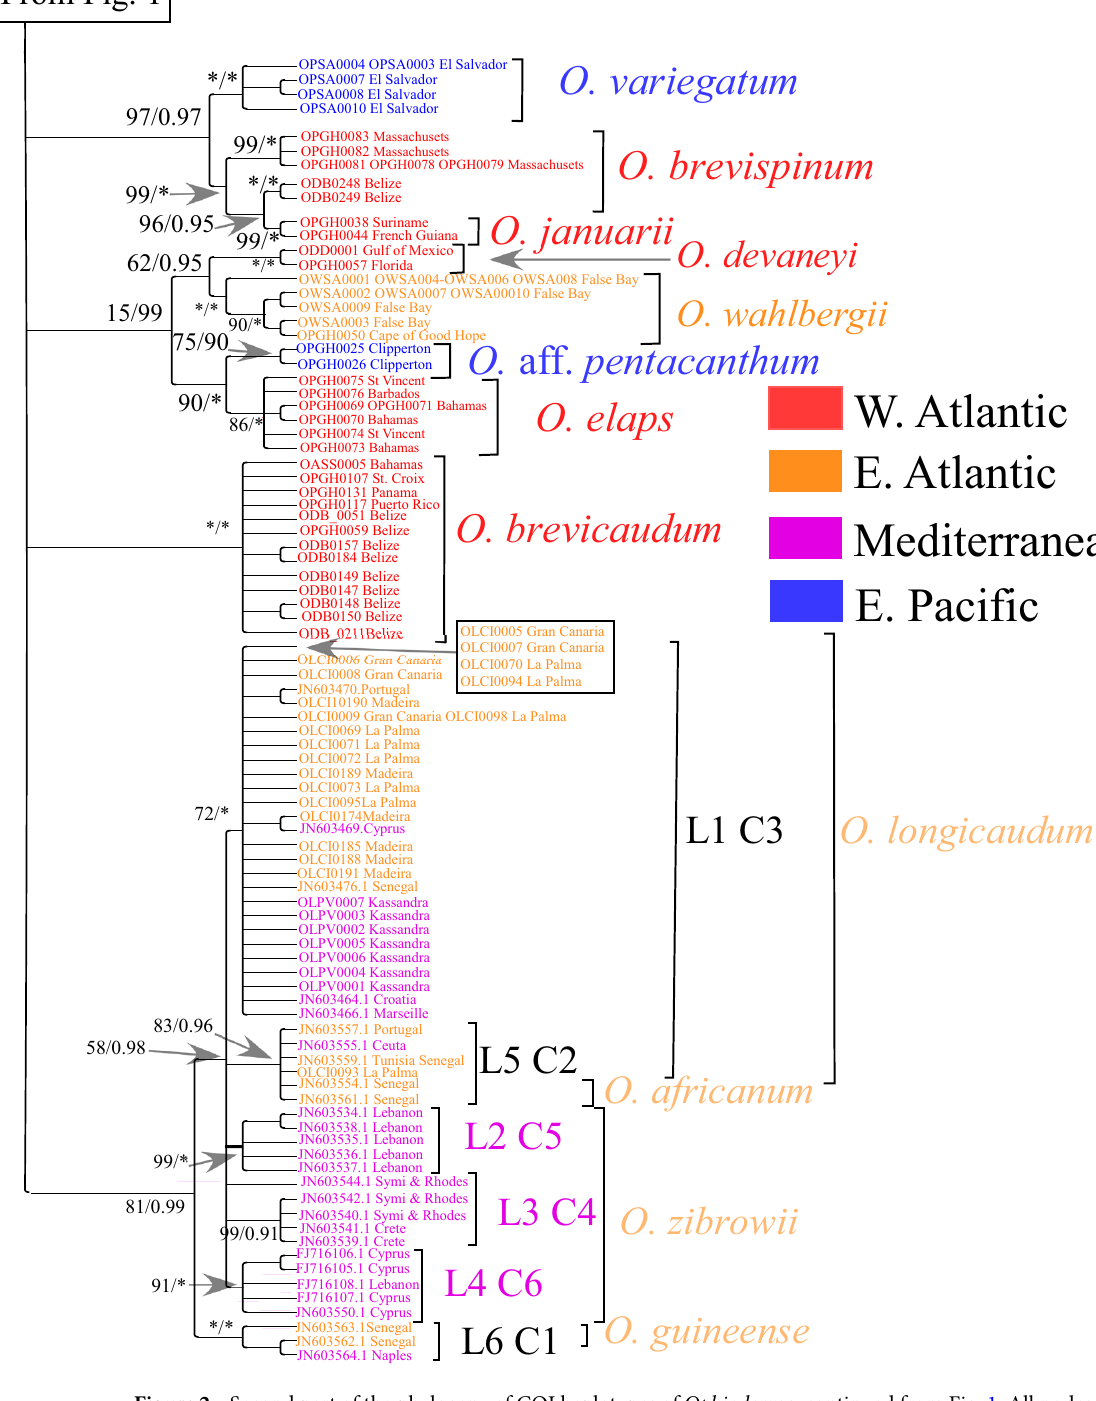
Figure 2. Second part of the phylogeny of COI haplotypes of Ophioderma , continued from Fig. 1. All nodes that did not receive support of at least 80% in ML or 0.9 in BI have been collapsed. Numbers next to nodes indicate ML and BI support (in this order). Codes indicate individuals in which a haplotype was present. Asterisks indicate support of 100%. Haplotypes obtained from the study of Boissin, et al. 14 are identified by codes that start with either “JN” or “FJ” (GenBank numbers). Clade labels starting with “L” are those designated by Boissin, et al. 14 , labels starting with C are from Weber et al. 101